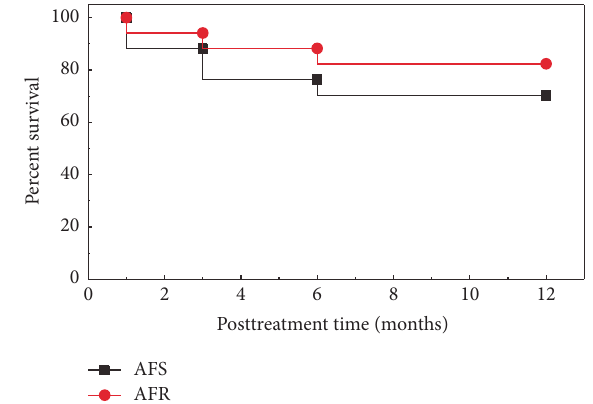
Figure 8: Kaplan-Meier analysis of major amputation-free survival and major amputation-free